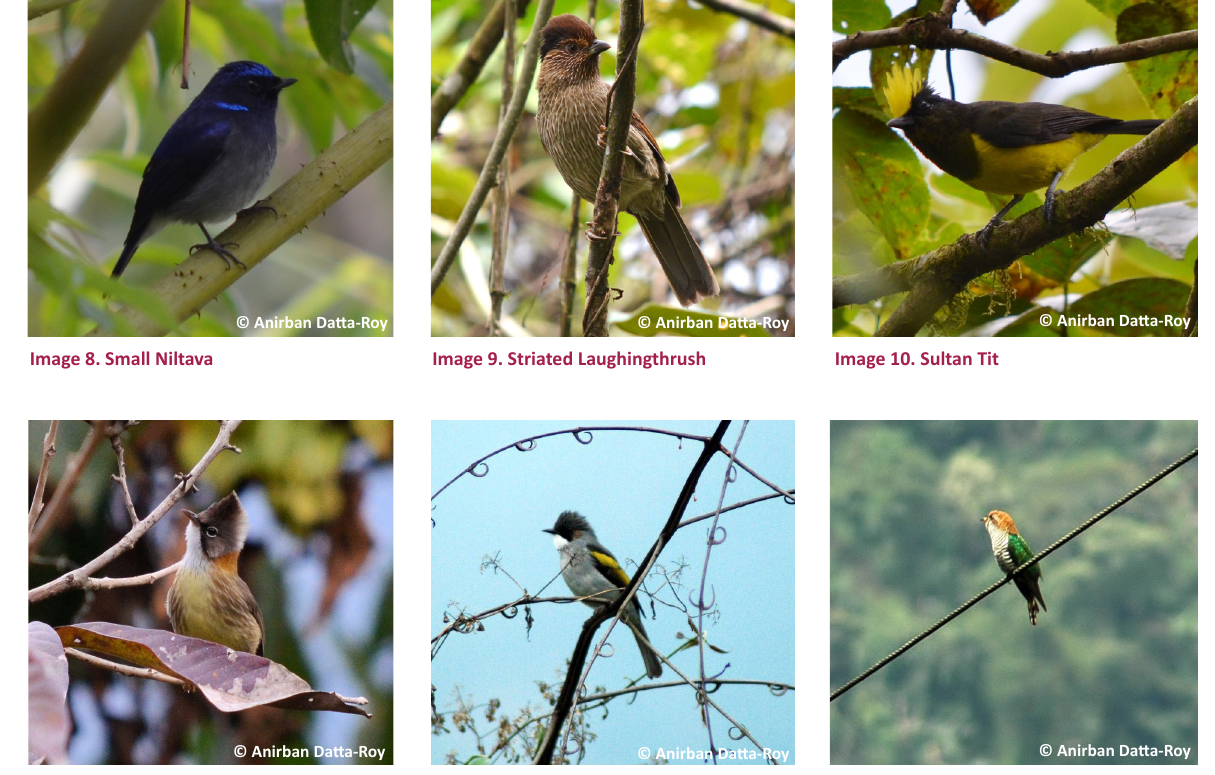
Image 11. Whiskered Yuhina Image 12. Ashy Bulbul Image 13. Asian Emerald